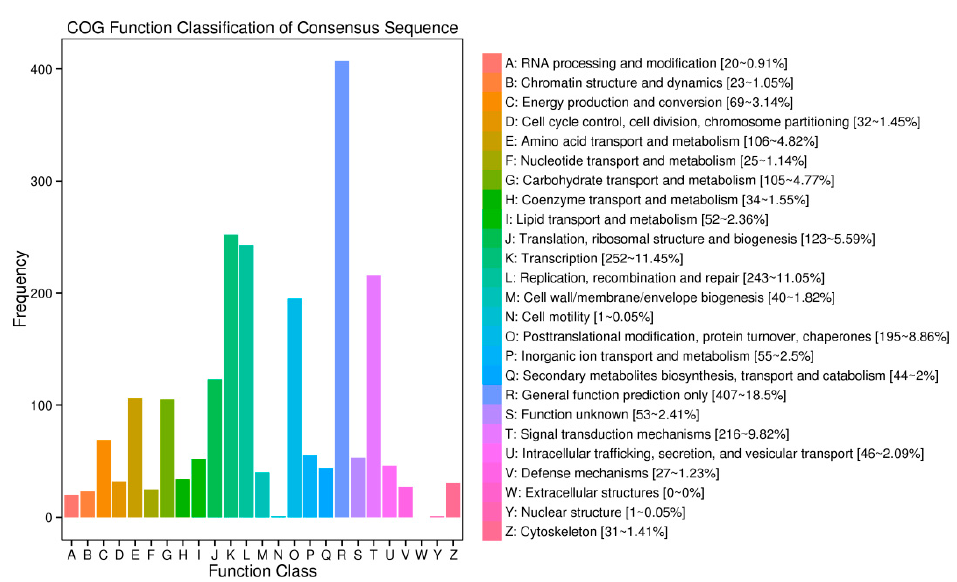
Figure 4. Cluster of genes (COG) classifications of host-genes (protein-based genes) of circRNAs.